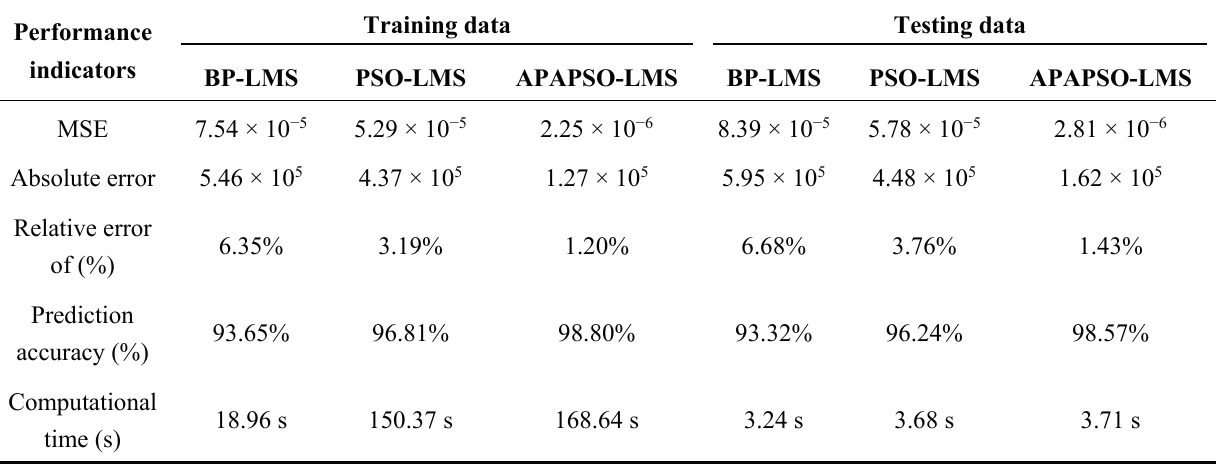
Table 1. Performance comparison